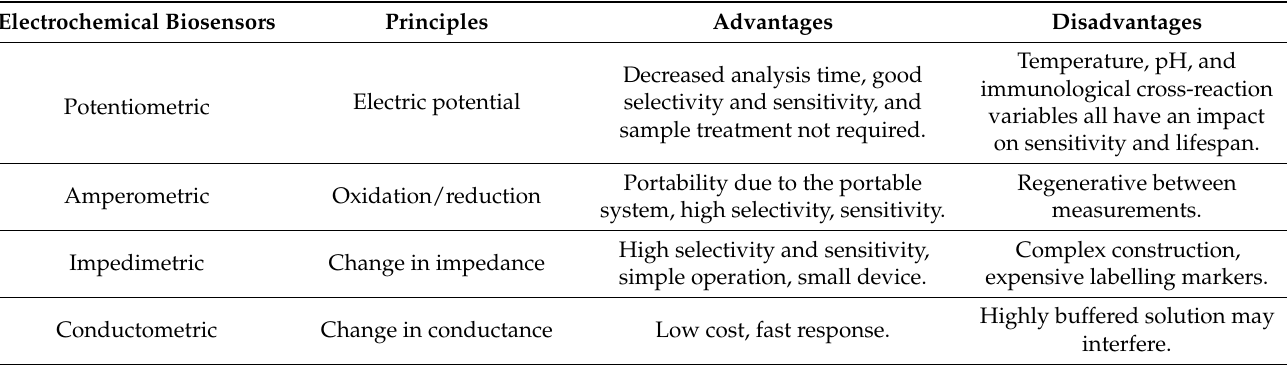
Table 3. Electrochemical biosensors with principles, advantages, and disadvantages. Electrochemical Biosensors